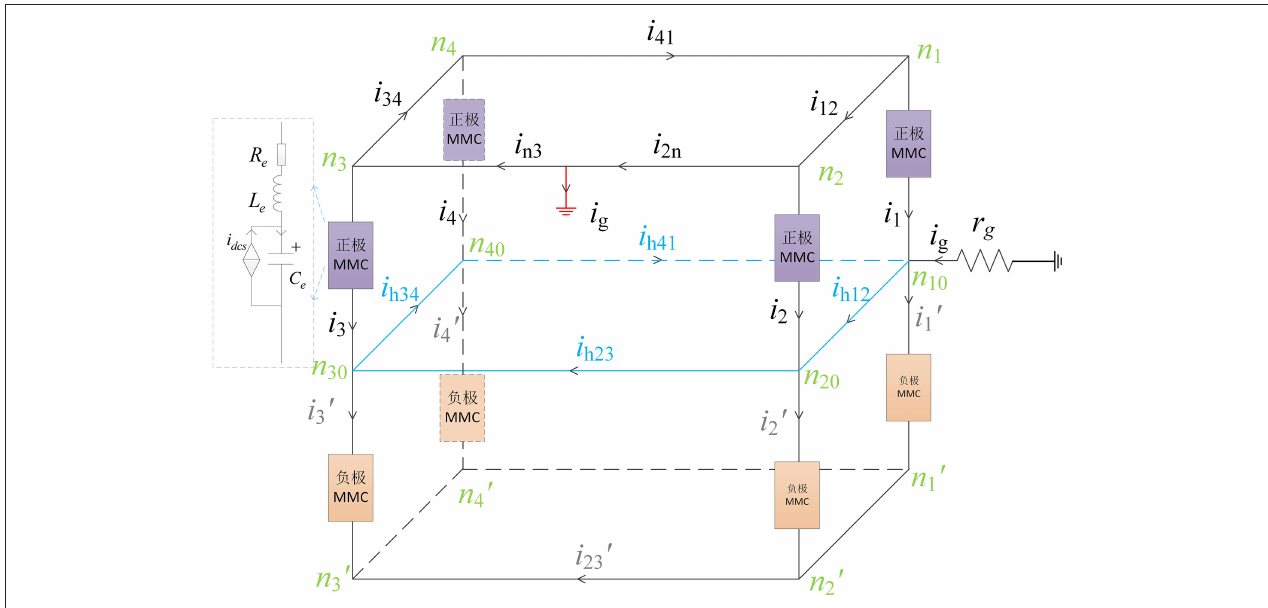
FIGURE 2 | A four-terminal DC equivalent circuit network